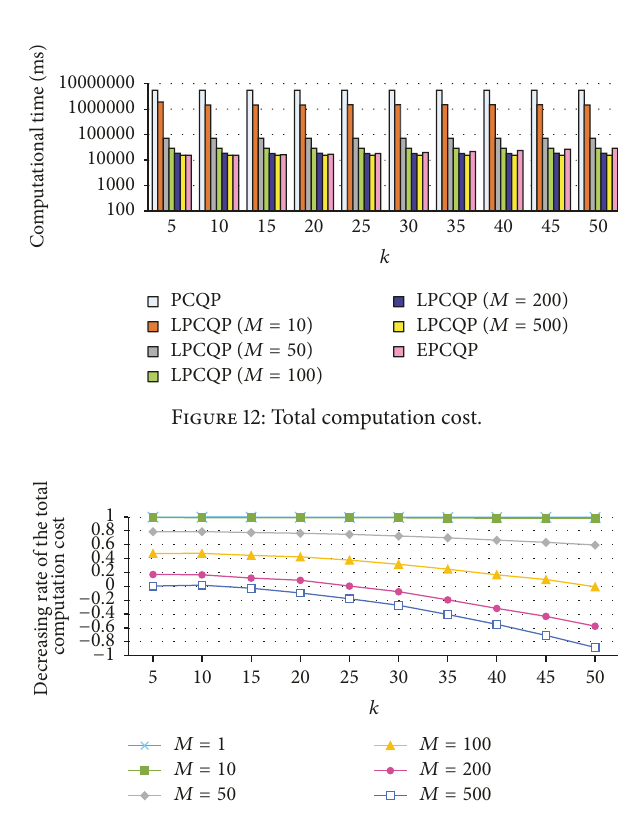
Figure 13: Decreasing rate of the total computation